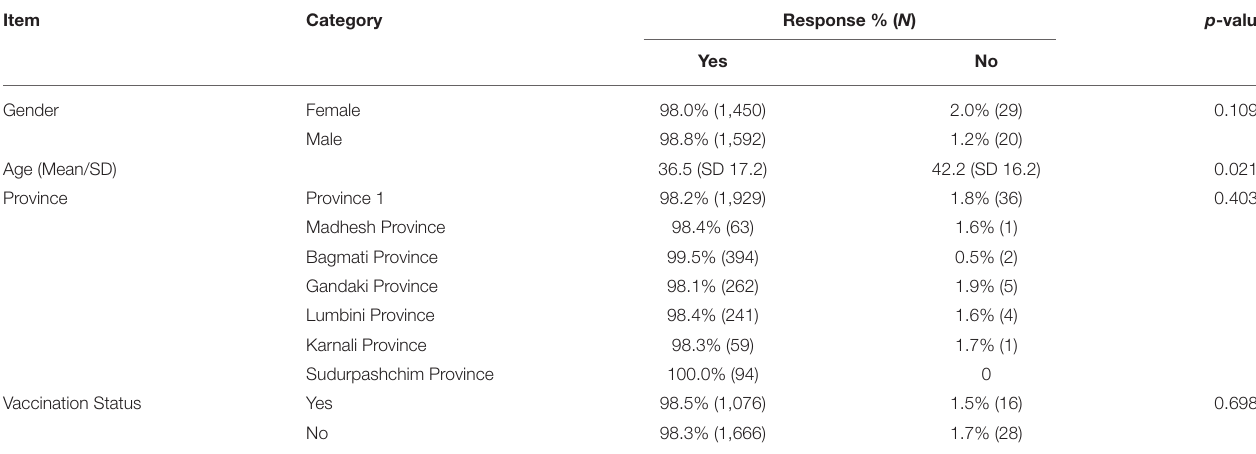
TABLE 2 | “Prevention of hospitalization” by gender, age, province, and vaccination status.